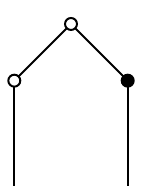
Figure 1: C , eternal independent set 5